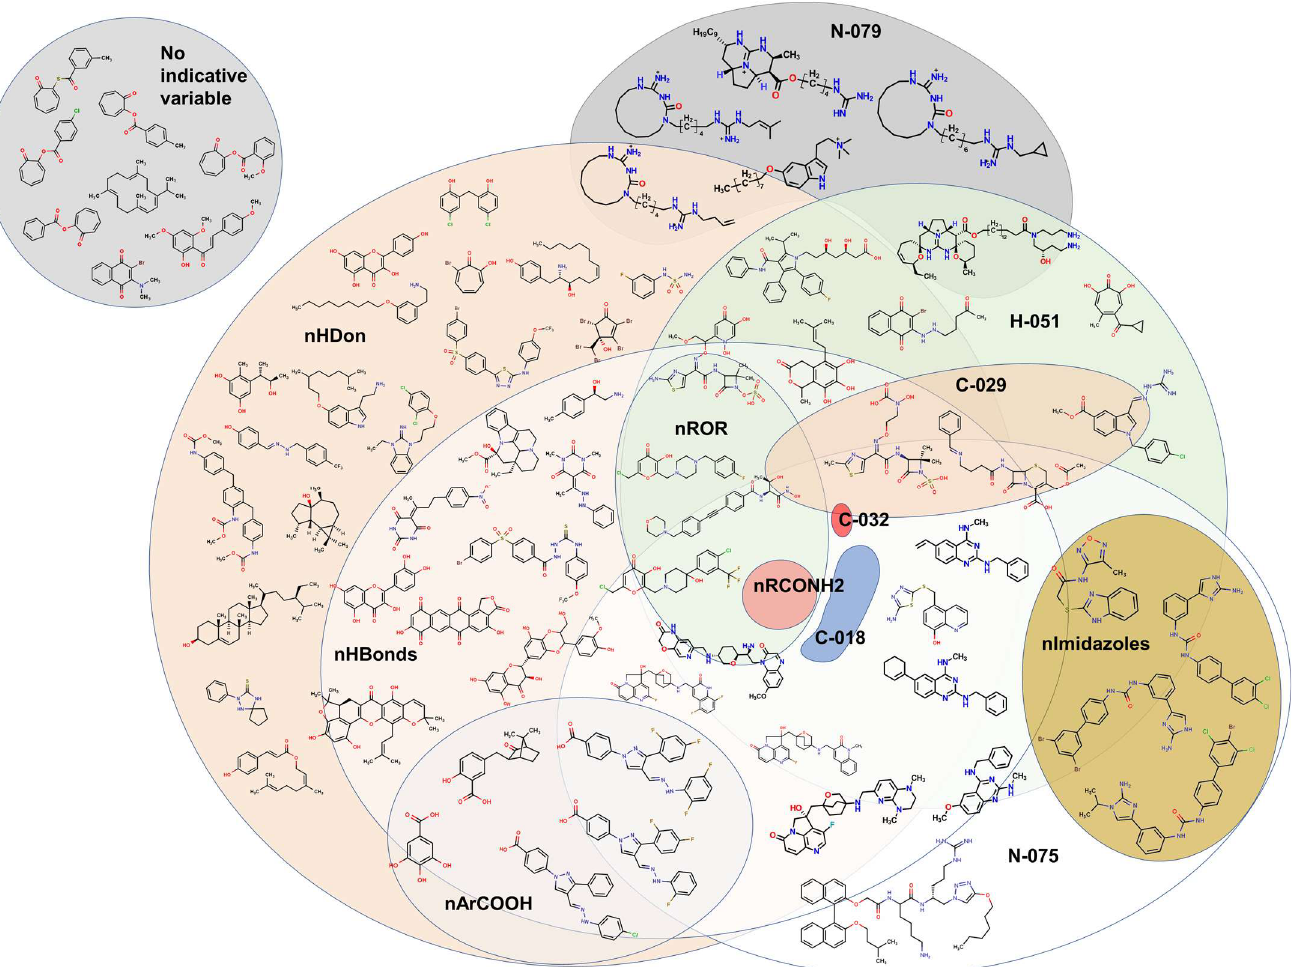
Figure 13. Venn diagram showing representative molecules from the dataset classified by the presence of at least one molecular descriptor and their correlations. Molecular descriptors used for the Venn diagram are nHDon, nHBonds, nArCOOH, nRCONH2, nROR, nImidazoles, C018, C029, C032, H051, N075, N079.